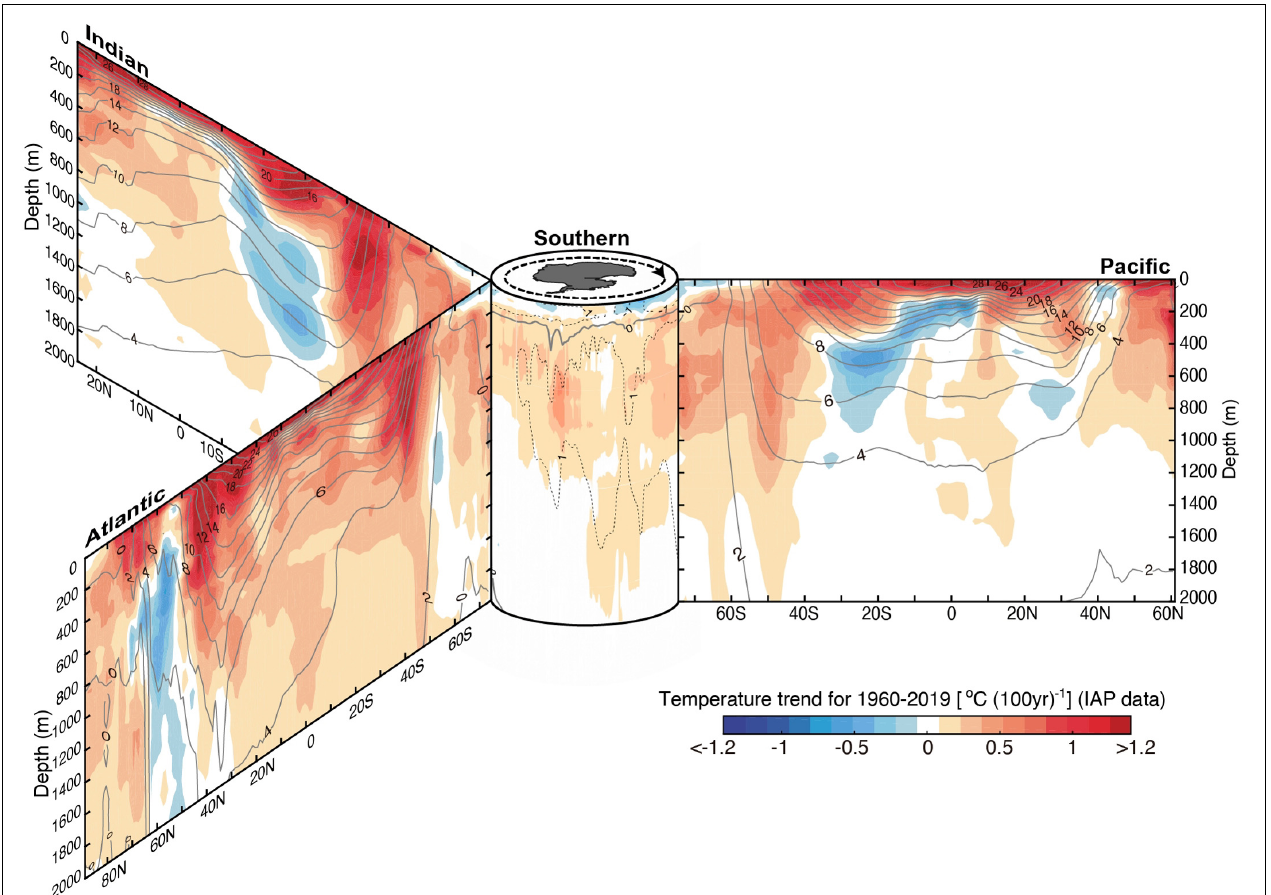
FIGURE 2 | Vertical section of the ocean temperature trends ( ◦ C per century) from the sea surface to 2,000 m depth in the period 1960–2019 (60-year ordinary least-squares linear trend). Shown are the zonal mean sections in each ocean basin organized around the Southern Ocean (south of 60 ◦ S) in the center. Black contours show the associated climatological mean temperature with intervals of 2 ◦ C (in the Southern Ocean, 1 ◦ C intervals are provided in dashed contours). Figure from Cheng et al. (2020).